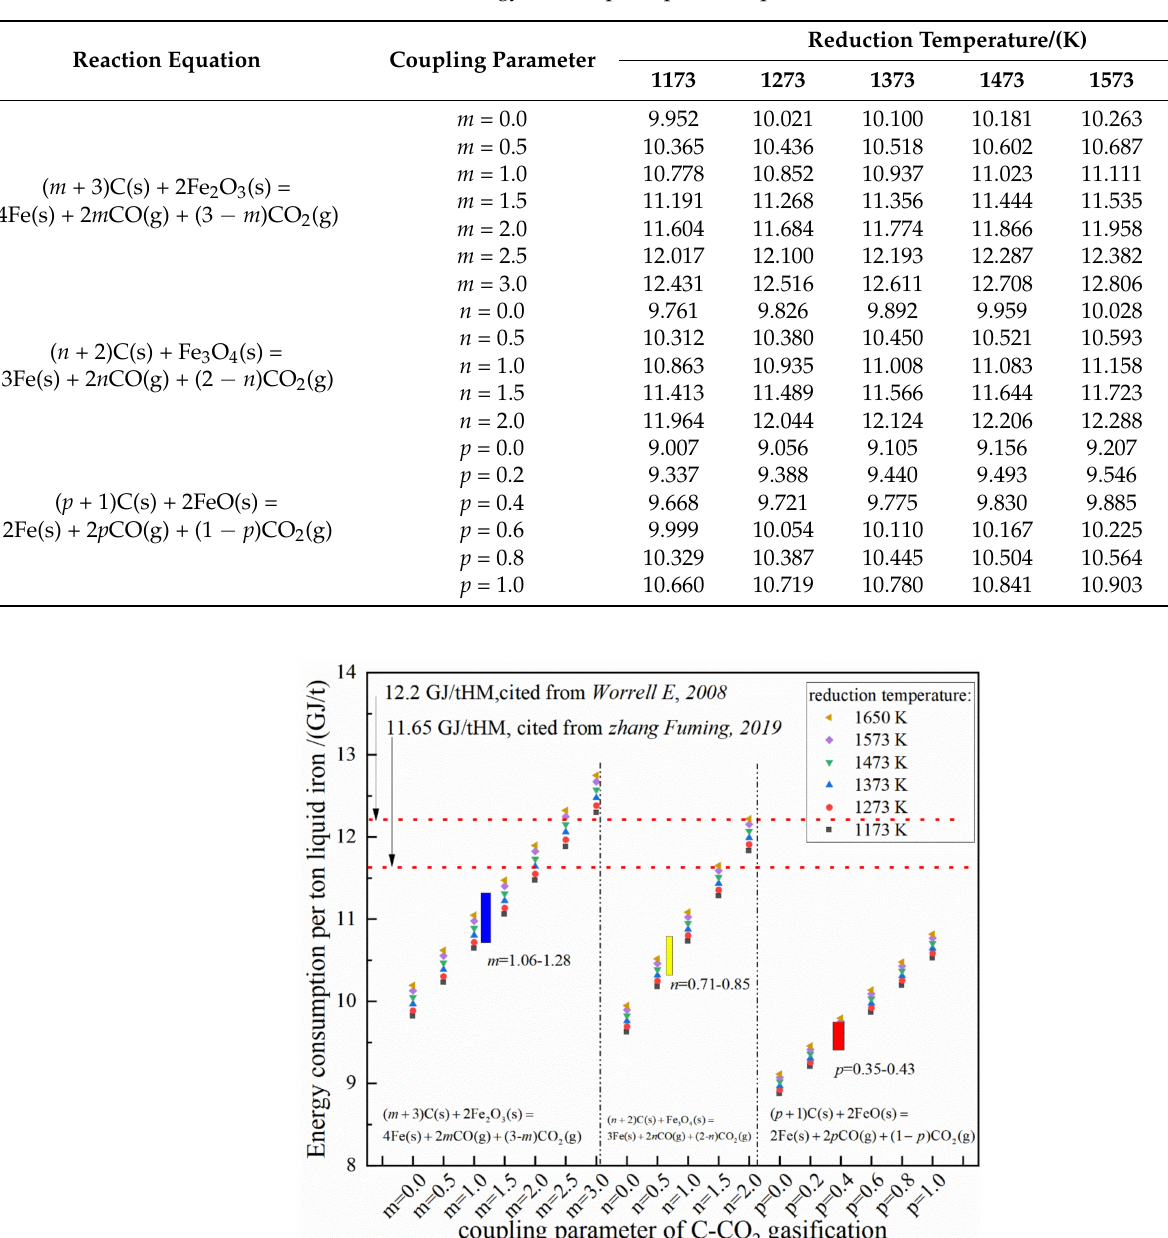
Table 7. The energy consumption per ton liquid iron (GJ/t).